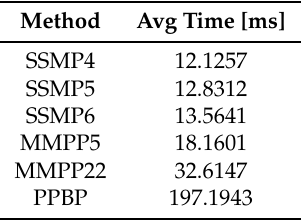
Table 2. Comparison of time needed to generate 1 million packets using the different